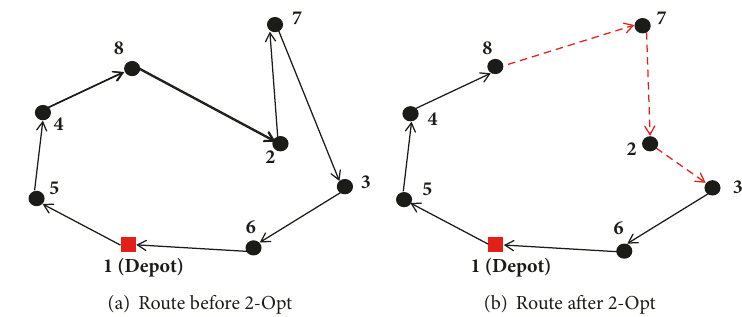
Figure 5: The demo of 2-Opt operation.